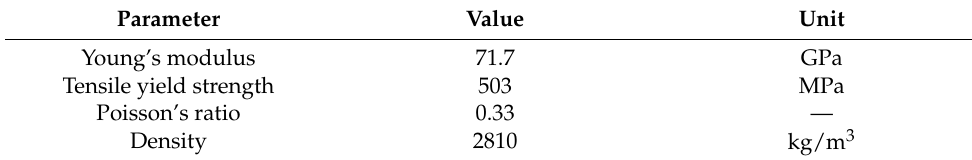
Table 3. Physical and mechanical parameters of the material Al7075-T651.